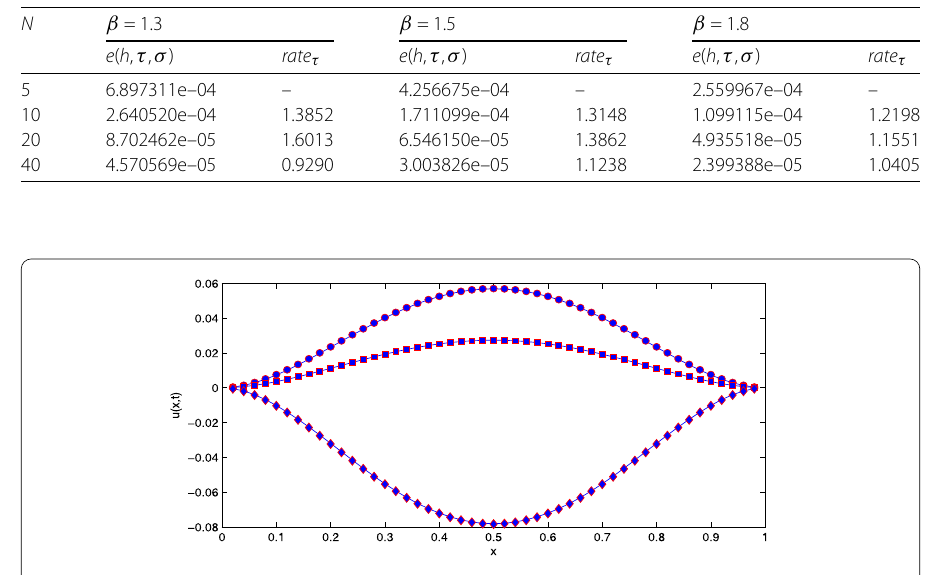
Figure 1 Exact solutions (lines) and numerical solutions (symbols) of Example 5.1 with β = 1.8 at t = 0.3 (rounds), t = 0.75 (squares), t = 1.5 (rhombus)